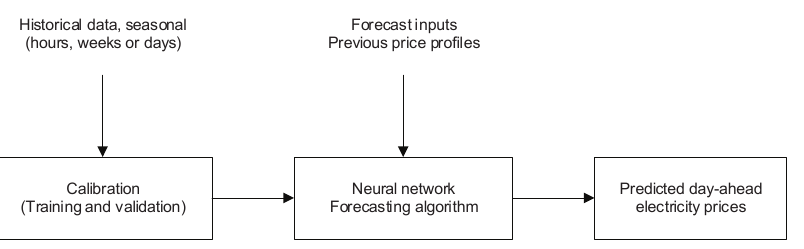
Figure 2. Schematic model of forecasting algorithm.